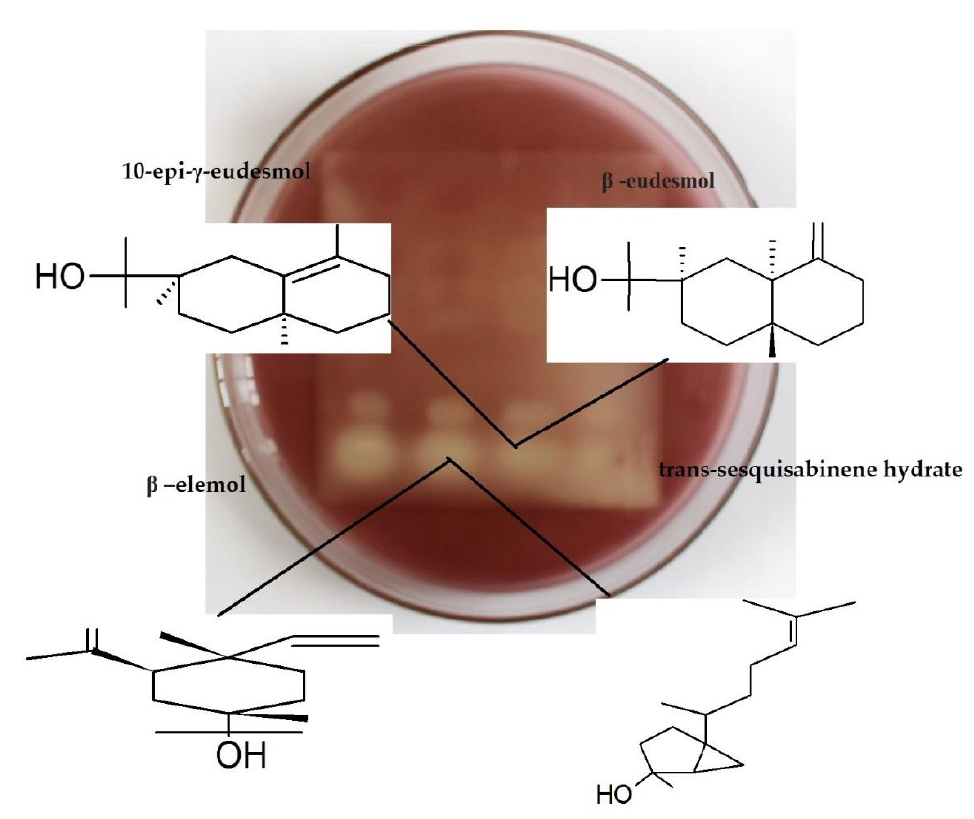
Figure 1. Antimicrobial bioautography against Staphylococcus aureus , Gram-positive bacteria. The four molecules involved correspond to the group of hydroxylated sesquiterpenes (molecules with 15 carbon atoms and OH